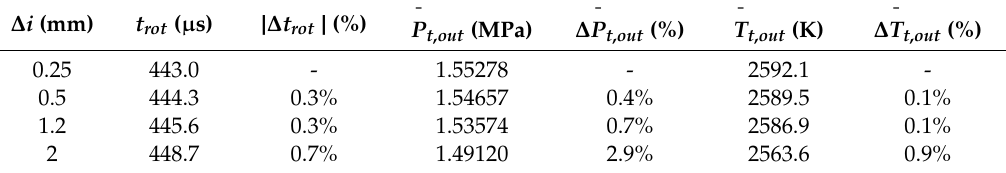
Figure 2. Grid used in the present numerical study. Table 1. Grid size independence verification (time step of 0.2 µ s).